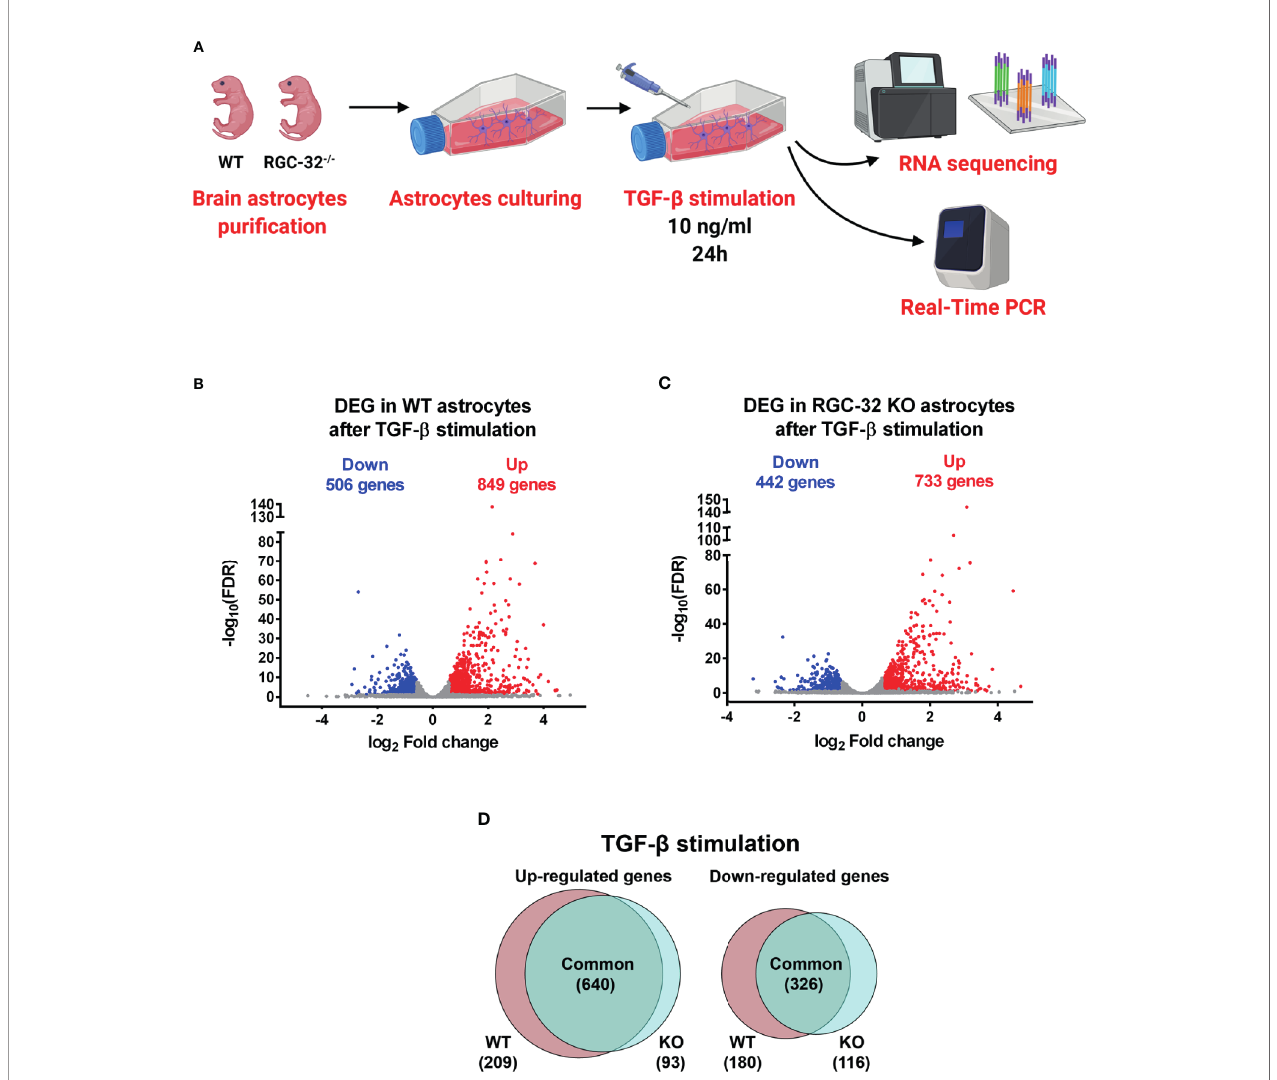
FIGURE 1 | DEG in WT and RGC-32 KO astrocytes after TGF- b stimulation. (A) Experimental design for the RNAseq study. (B , C) Volcano plots showing the total number of DEG in WT (B) and RGC-32 KO astrocytes (C) . (D) Venn diagrams of the intersected DEGs showing the DEG common to both genotypes and those differentially expressed only in one genotype but not the